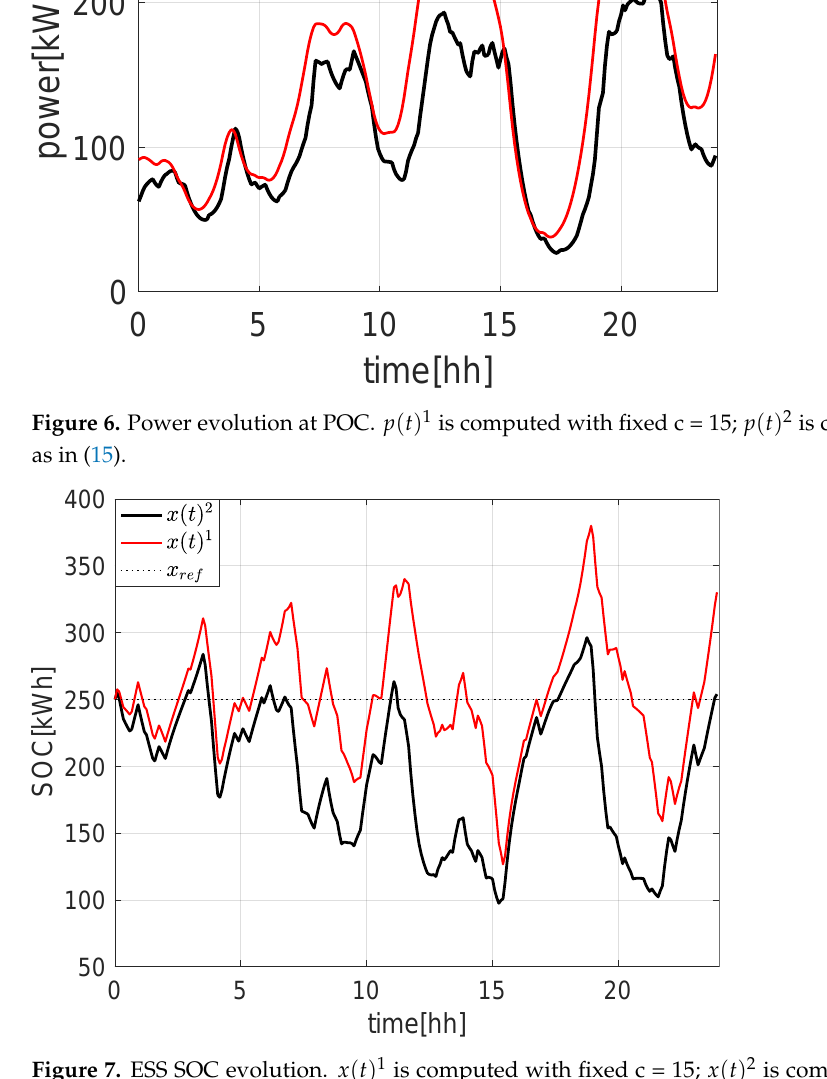
Figure 7. ESS SOC evolution. x ( t ) 1 is computed with fixed c = 15; x ( t ) 2 is computed with c(t), as in